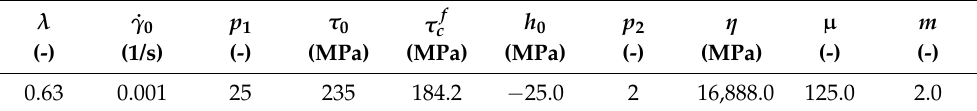
Table 5. Calibrated CPFE model parameters (set